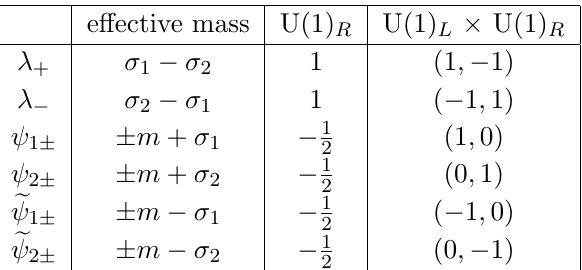
Table 5 . The e(cid:11)ective mass, R-charge and gauge charge of the fermions under U(1) (cid:2) U(1). Here, (cid:21) (cid:6) denote gauginos and ( e ) is a complex fermion in the chiral multiplet in the fundamental (anti-fundamental)